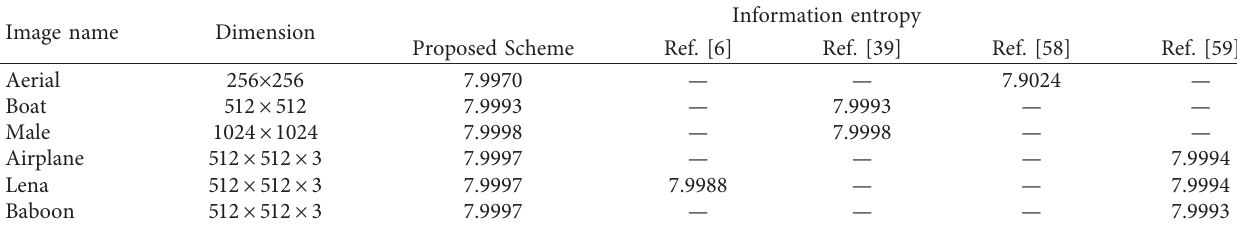
Table 7: Information entropy comparison.